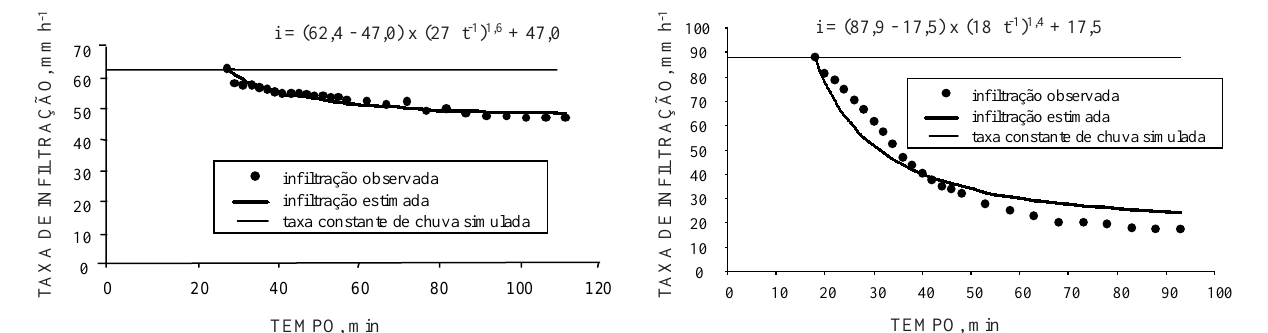
Figura 2. Taxas de infiltração observadas e estimadas para plantio direto sob chuva simulada, com intensidade média constante de 62,4 mm h -1 . Médias de quatro repetições e duas observações por repetição.